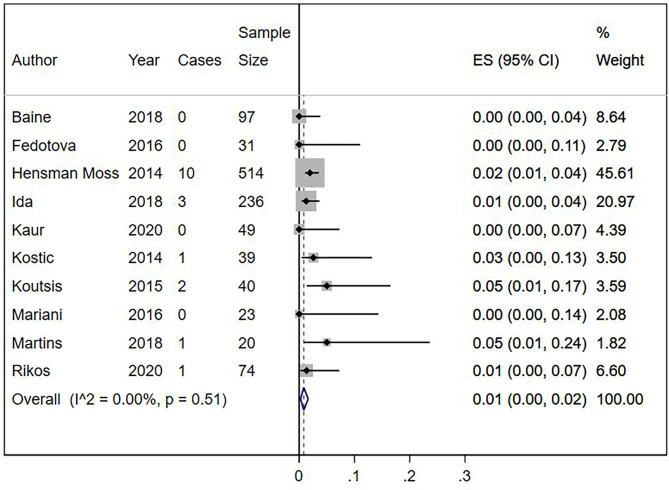
Percentage of C9orf72 hexanucleotide repeat expansion in Huntington Disease-Like patients. Meta-analysis of 10 studies for prevalence of C9orf72 hexanucleotide full repeat expansion in Huntington Disease-Like patients. ES, Estimated proportion; 95% CI, 95% Confidence interval.